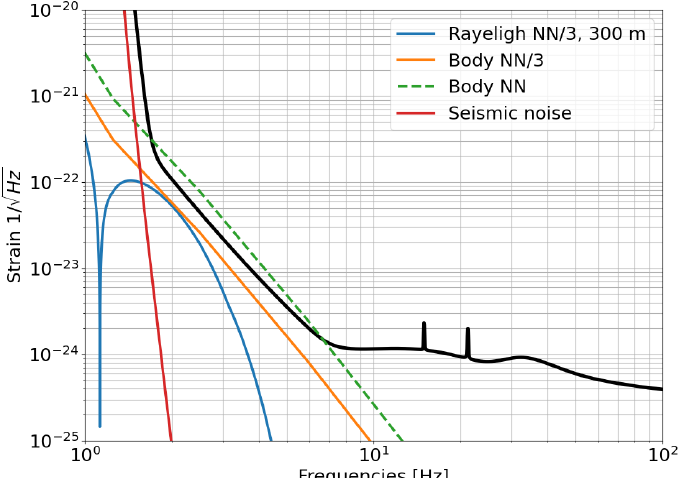
Figure 12. ET-D sensitivity curve compared with the seismic noise and NN of seismic origin. The seismic noise curve was obtained using a seismic spectrum lying exactly at the midpoint between Peterson’s NLNM and NHNM (see Figure 2). The same spectrum was used to evaluate the NN generated by Rayleigh waves. For the NN from body waves, we used 5 times the Low Noise Model spectrum, as was done in